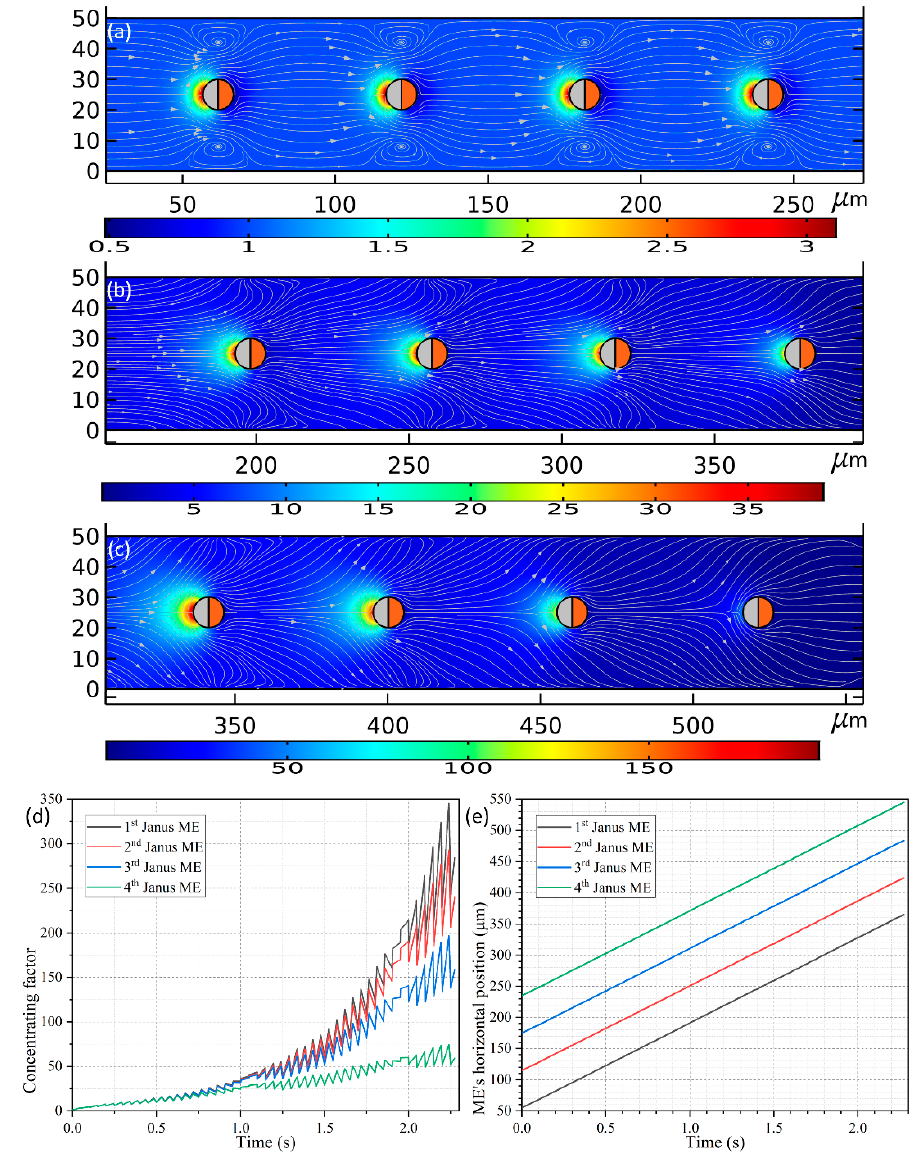
Figure 10. A simulation study of the feasibility of an array of Janus ME with four motile PP arranged along the channel centerline driven by e-DEP force in continuous collection of secondary biomolecules from a 0.1S/m buffer medium with an AC voltage signal of 1.5 V and 500 MHz. ( a – c ) An arrowed streamline plot of the hydrodynamic flow field around the array of the Janus ME experiencing e-DEP force, and a surface plot of the concentration field of the biomolecules (unit: nM) inside the fluidic chamber, at ( a ) t = 0.05 s, ( b ) t = 1.05 s, ( c ) t = 2.1 s (See Supporting Video S5). ( d ) Temporal evolution of the concentrating factor of the target biomolecules on the surface of the sequential PP as the ME array moves via e-DEP motion. ( e ) Time-dependent horizontal location of the four motile electrodes as they transport unidirectionally towards downstream, from which a time-averaged e-DEP translational velocity of 136.318 μ m/s is obtainable.